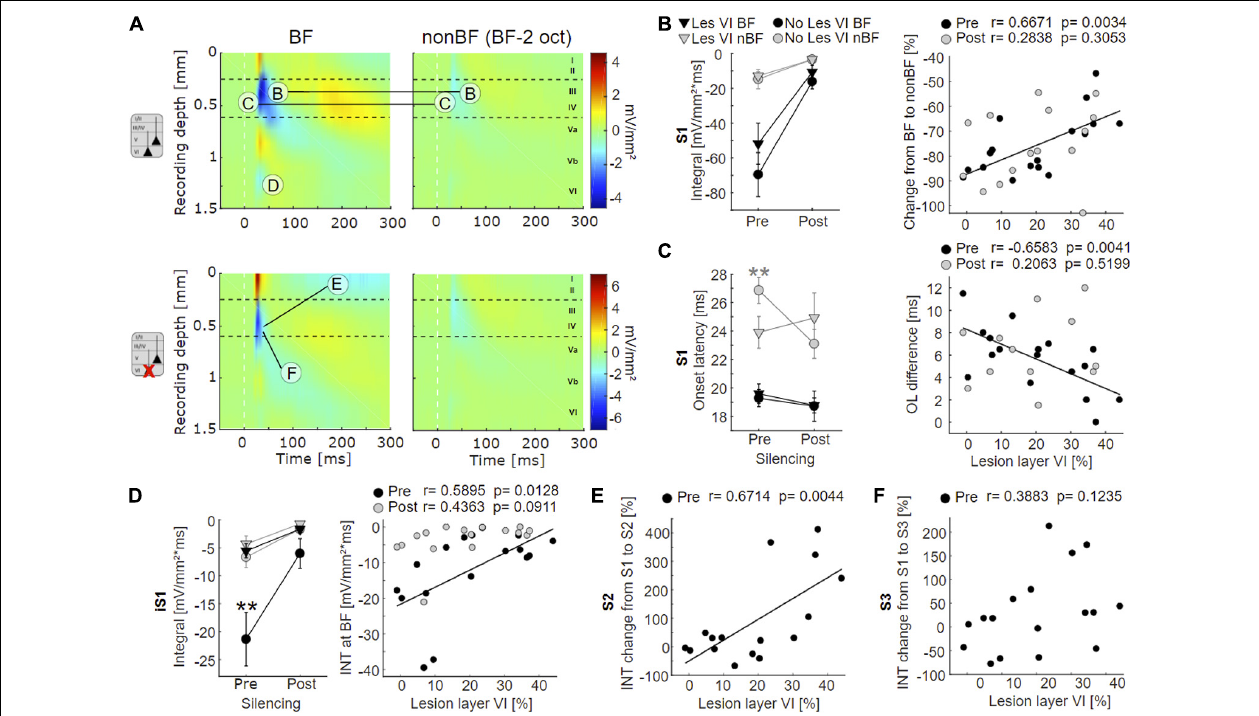
FIGURE 4 | Effects of layer VI lesions on acoustically evoked cortical activity. (A) On the left, exemplary CSD profiles of a non-lesioned (case G04) and a layer VI lesioned (case G10) animal are represented, both at BF and at non-BF (2 octaves below BF). The letters refer to specific parameters and spatial locations used for the quantitative analyses shown in 4B-F. (B) Left: Means ± SEM of S1 integrals (INT), before and after application of muscimol at BF (black) and non-BF (gray), comparing animals without lesions in layer VI (circle) and those with lesions in layer VI (triangle). There is a trend toward stronger activation at BF in non-lesioned animals. Right: Relationships between lesion strength in layer VI and percentual change of non-BF INT, before (black circles) and after (gray circles) cortical silencing. In the pharmacologically untreated cortex, the reduction of activation strength becomes gradually smaller (less negative) with lesion strength. (C) Left: Means ± SEM of S1 onset latencies (OL). Non-lesioned animals have longer latencies at non-BF than layer VI lesioned animals before, but not after cortical silencing. Right: Negative correlation between latency differences (OL non − BF – OL BF ) and lesion strength in layer VI (pre-muscimol). (D) Left: Means ± SEM of early infragranular sink (iS1) integrals. Layer VI lesioned animals have weaker sinks at BF than animals without lesions in layer VI. Right: Significant linear correlation between lesion and activation strength before muscimol treatment. (E) Linear correlation between relative S2 strength and lesion in layer VI. S2 is relatively stronger in layer VI lesioned animals. (F) No significant correlation between relative S3 strength and lesion in layer VI. Asterisk in (C,D) display significant group differences according to linear mixed effects model with grouped data ( Supplementary Table 2A ). * p < 0.05, ** p <